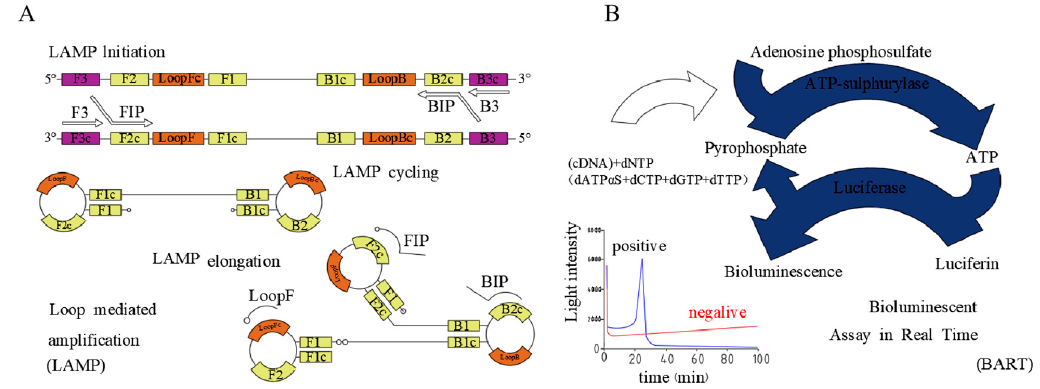
Figure 1. RT-LAMP-BART and LAMP assay principles. ( A ) RT-BART schematic. ( B ) LAMP